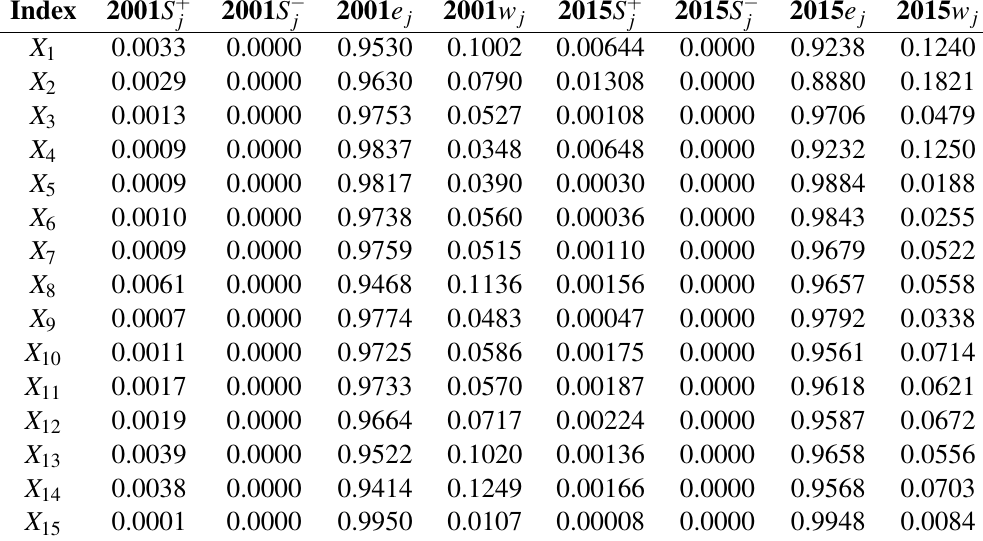
Table 2 The best solution, worst solution, entropy, and weight of each